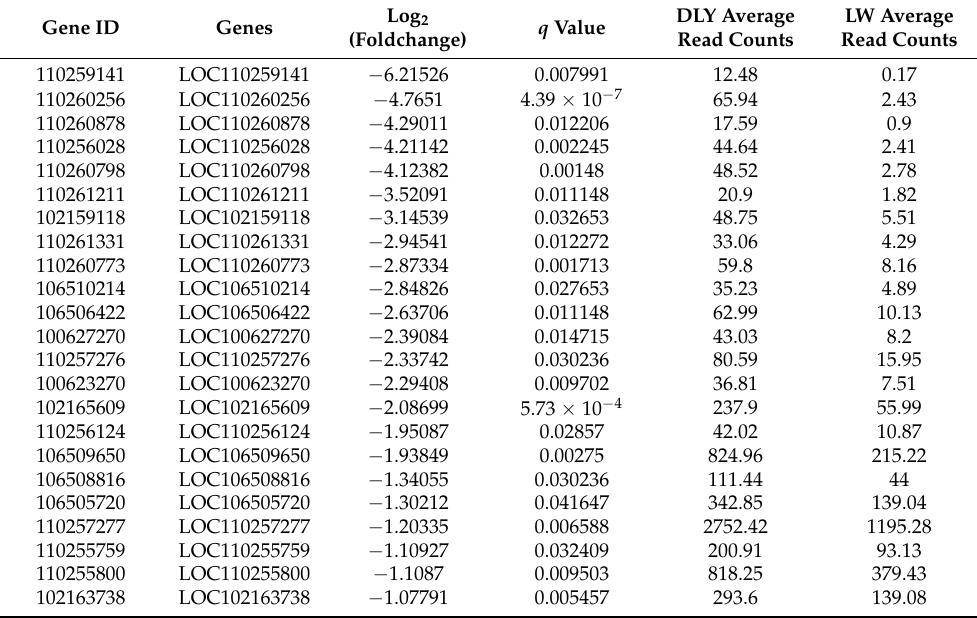
Table 8. The downregulated lncRNAs in the Longissimus dorsi muscle sample of LW